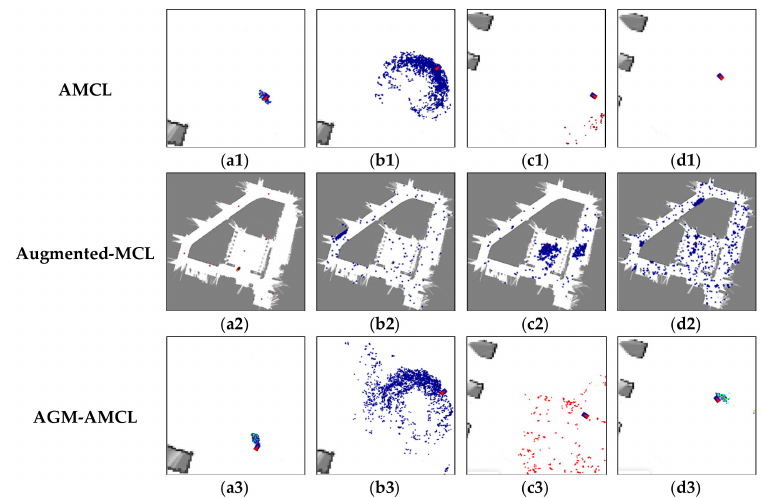
Figure 12. Evolution of particles using AMCL ( top ), Augmented-MCL ( middle ) and AGM-AMCL ( bottom ) in scene B. The letters a , b , c and d denote four locations shown in Figure 11(b1) with red dots. The blue square with a red triangle inside represents the true pose and the colored points denote particles. With some particles in the nearby unambiguous area, our method can converge to the true pose after a robot moving through an ambiguous